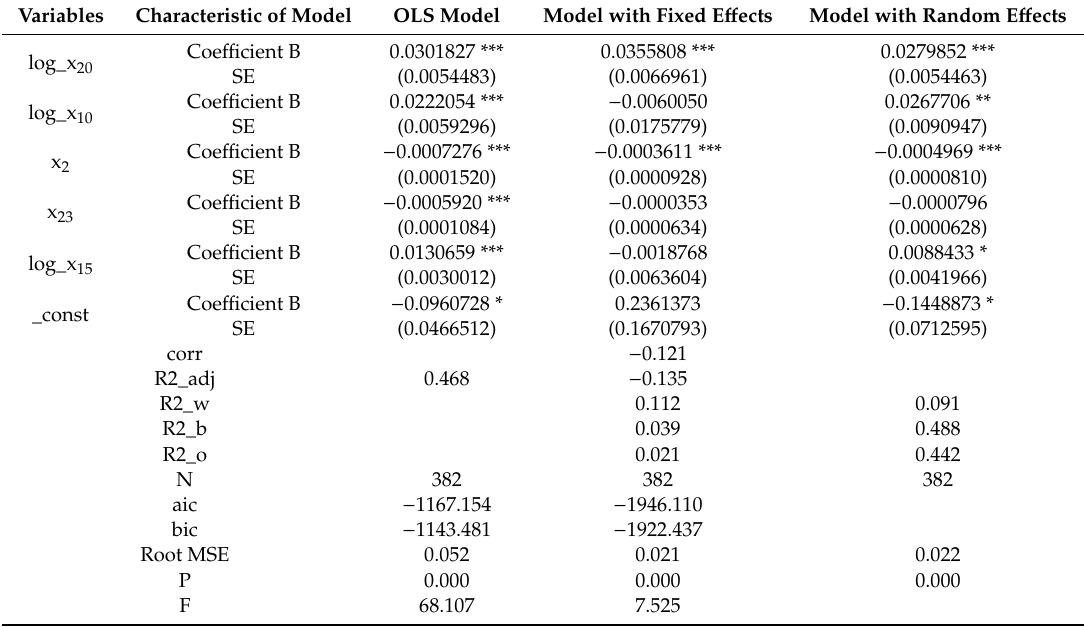
Table 5. Evaluation of the regression models by the method of estimating the least squares (OLS), taking into account the fixed and random e ff